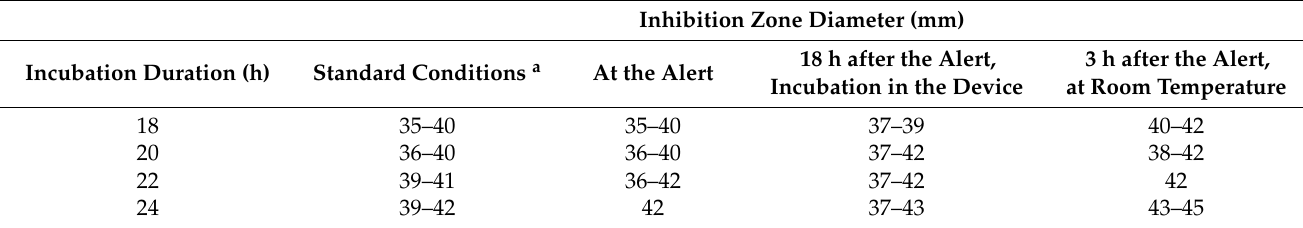
Table 10. Ciprofloxacin inhibition zone diameters of Y. pestis -positive blood cultures.